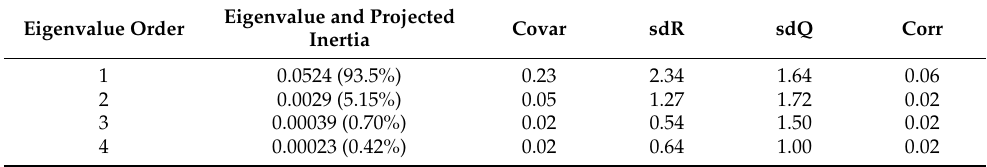
Table A5. Comparison of RLQ analysis results with ordinal multivariate data matrix analysis procedures.